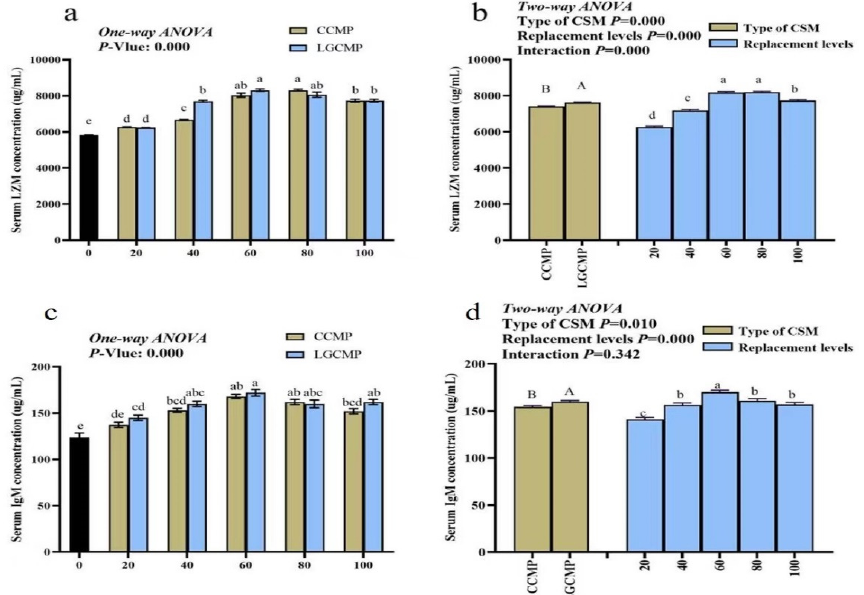
Figure 4. The concentration of LZM and IgM activity of in serum of hybrid grouper juveniles fed low-FM diets with different PMBP replacements by CCMP or LGCMP for 9 weeks. Superscript letters (a,b,c,d) represented significant difference among different PBMP replacement levels by CCMP or LGCMP while superscript letter (A,B) represented significant difference between CSM